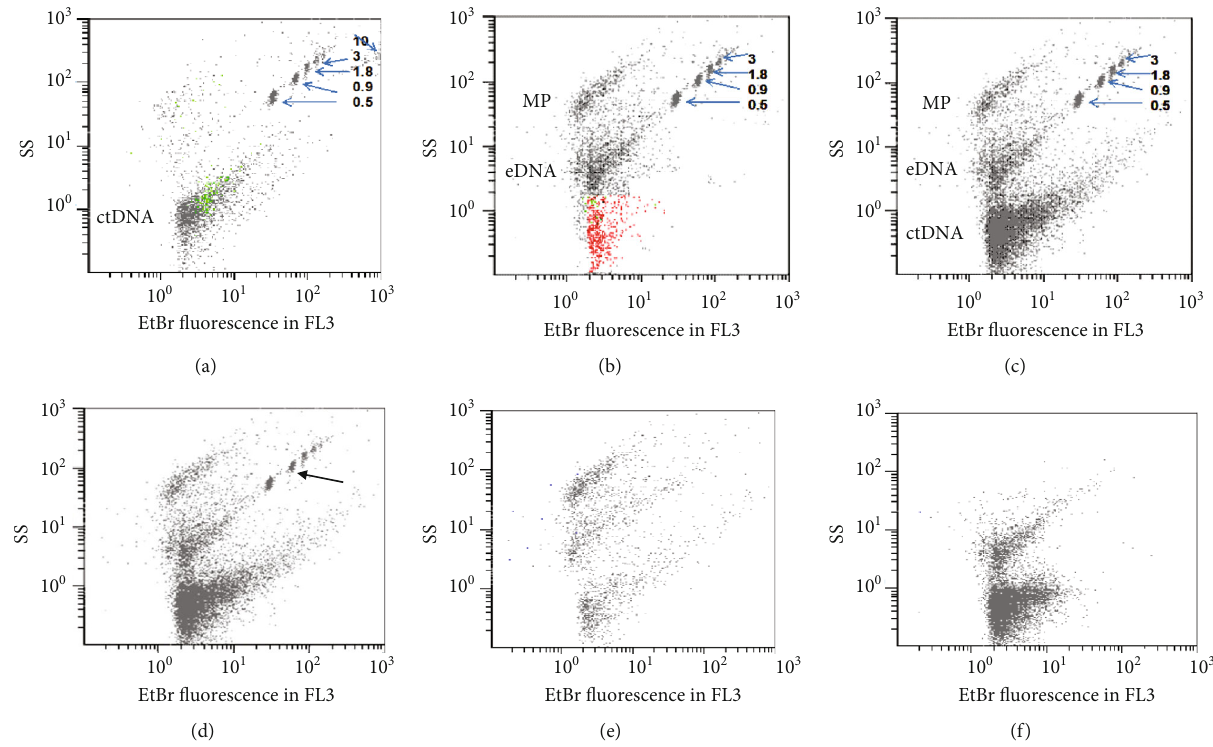
Figure 1: DNAse I and detergent sensitivity of serum particles detected by fl ow cytometry. The ordinate of histograms is the side scatter (SS) and the abscissa; the fl uorescence of DNA stained by ethidium bromide (EB), measured at 620nm (FL3). The discriminator was EB fl uorescence; only events tagged by EB are shown. Upper histograms. (a) Calf thymus DNA (ctDNA) at 10 μ g/ml. (b) A SLE serum sample with anti-DNA antibodies containing endogenous DNA (eDNA) and microparticles (MPs). MPs may be stained with EB because they may contain DNA. (c, d) The same serum sample incubated with 20 and 40 μ g/ml ctDNA. (e) The serum sample after incubation with 20 μ g/ml ctDNA was treated with DNAse I or (f) treated with Tween 80 diluted 1/1000. The arrows indicate size-calibrated 0.5, 0.9, 3, and 10 μ m fl uorescent beads. A microparticle gate was established using size-calibrated beads as described [27,